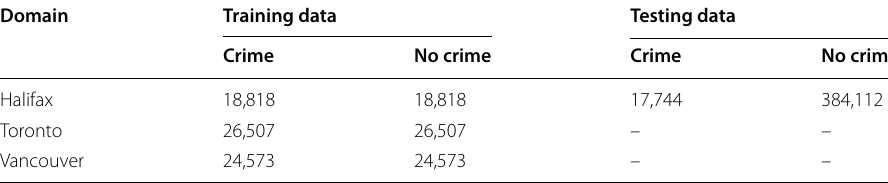
Table 5 Training and testing splits after data sampling and mapping